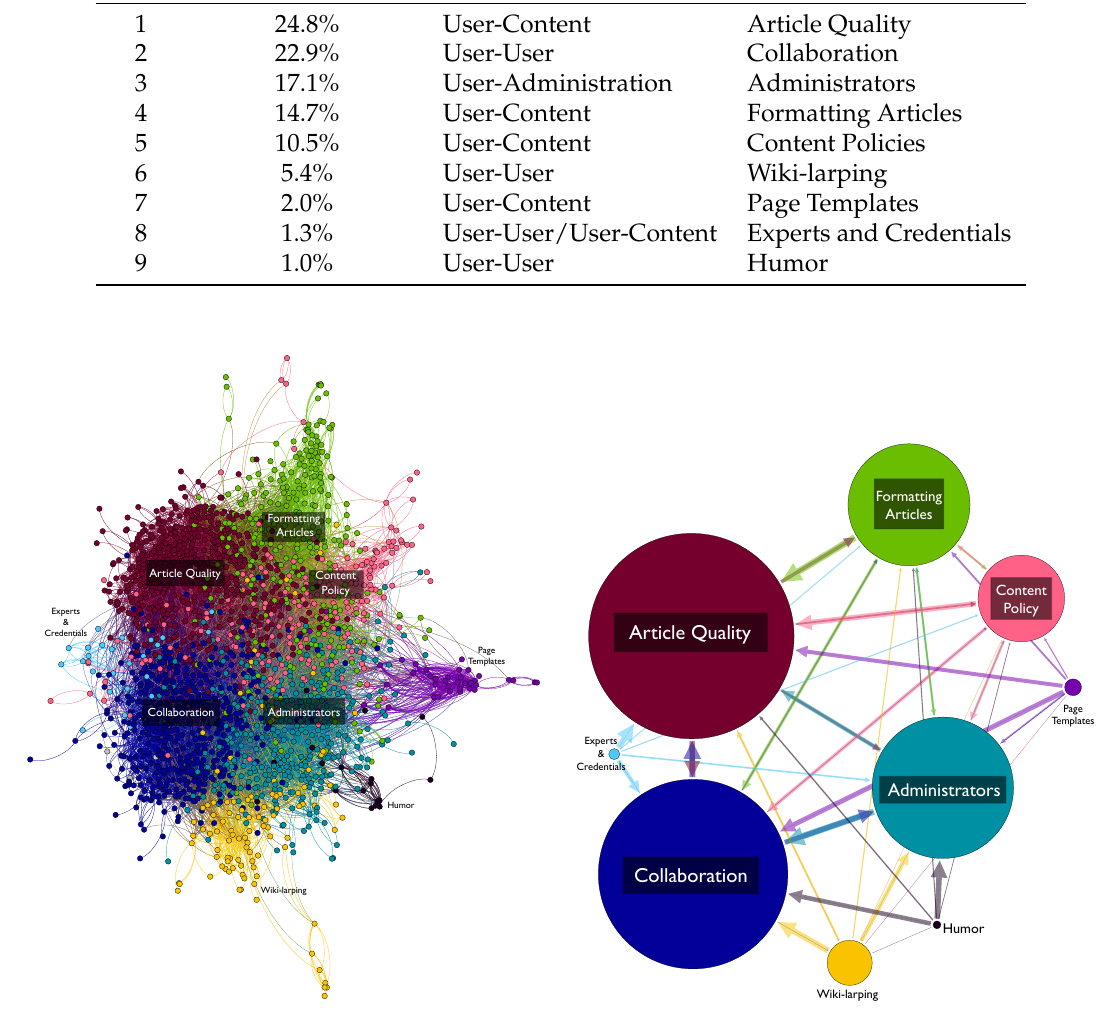
Figure 4. The topology of the norm network is organized around five central clusters, found using the Louvain algorithm. Cluster themes are based on a sample of high-eigenvector centrality (EC) nodes in each cluster and confirmed by reference to a topic model of word usage. Left panel: full network, with cluster membership indicated by color. Right panel: cluster structure. Each node is a Louvain cluster, and node size indicates cluster size by number of pages. Edge weights are defined as the fraction of the origin cluster’s out-links that link to each other cluster (self-loops are not